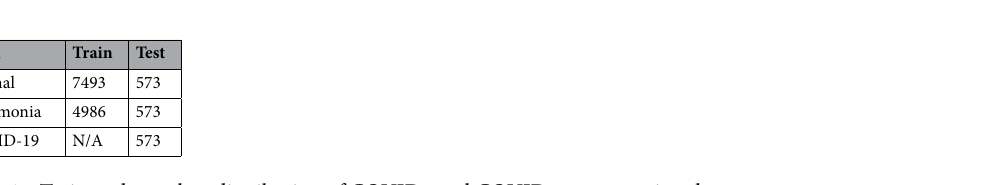
Table 1. Train and test class distribution of COVIDx and COVIDx segmentation